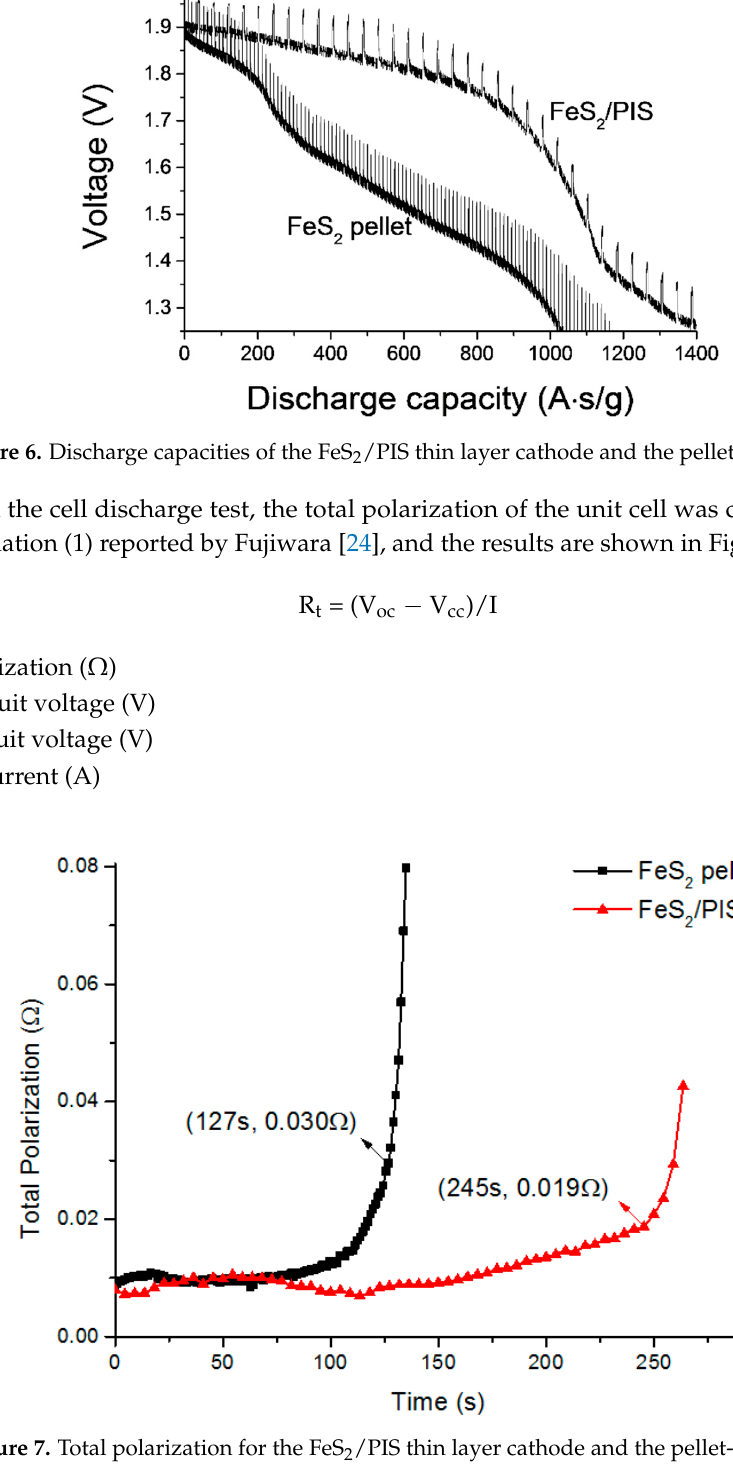
Figure 7. Total polarization for the FeS 2 /PIS thin layer cathode and the pellet-type FeS 2